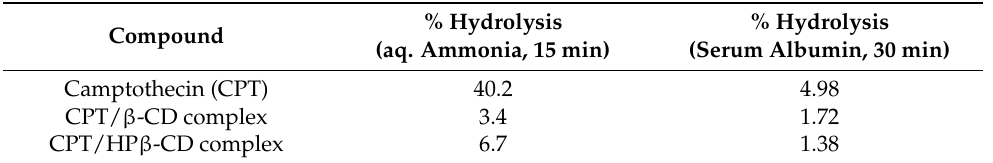
Table 2. Quantitative data showing the stabilization of camptothecin following formation of its cyclodextrin